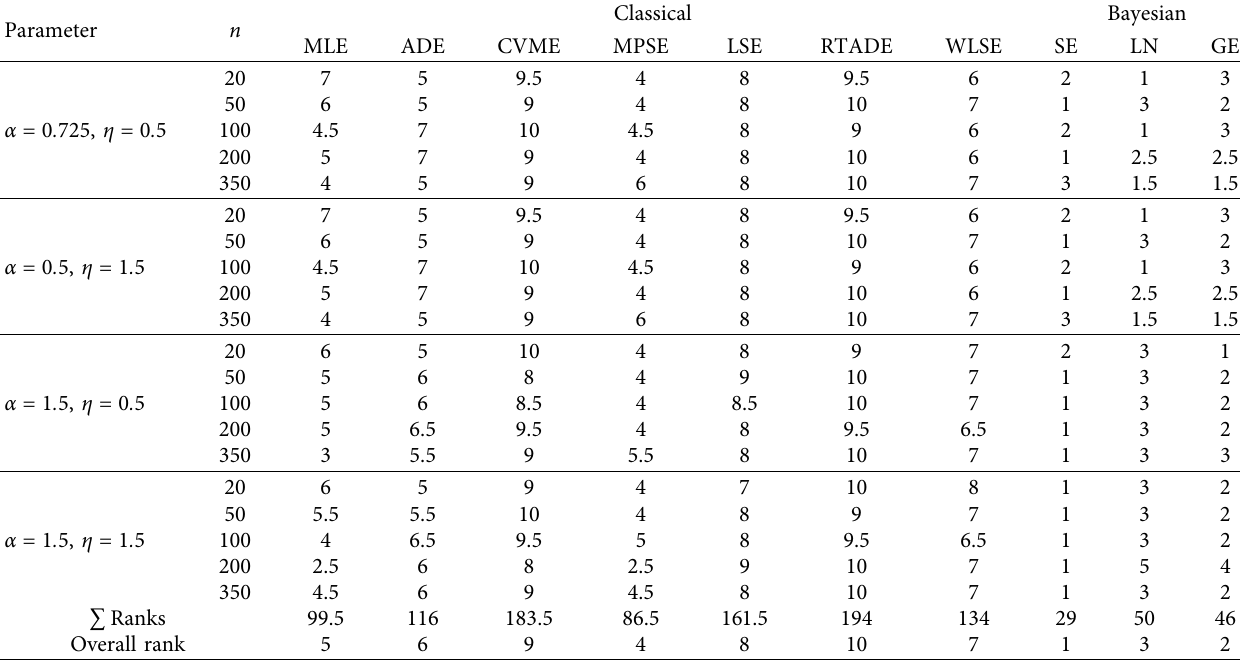
Table 5: Partial and overall ranks of the ten estimation methods for the IPBH distribution. Classical Bayesian Parameter n MLE ADE α � 0 . 725 , η � 0 . 5